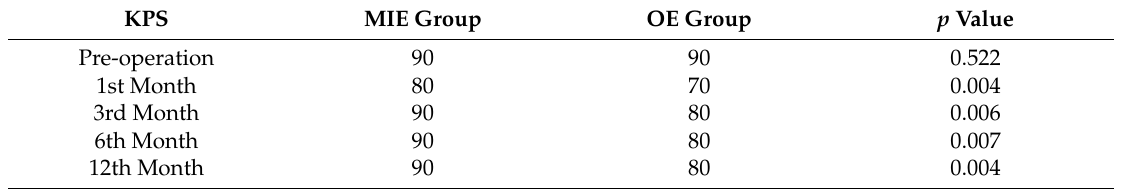
Table 2. The Comparison of Karnofshy performance scale (KPS) scores between the two